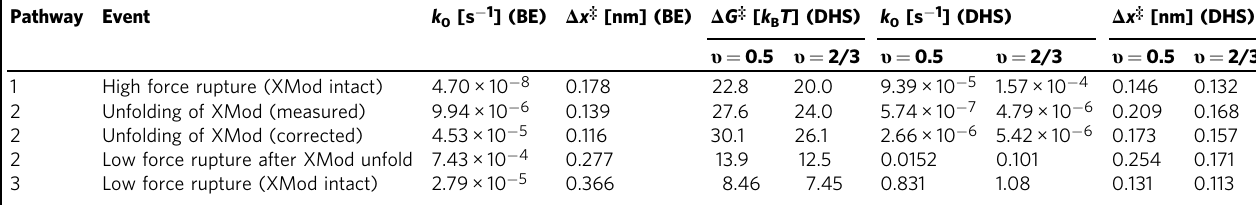
Table 1 Kinetic parameters extracted from AFM-SMFS. Pathway